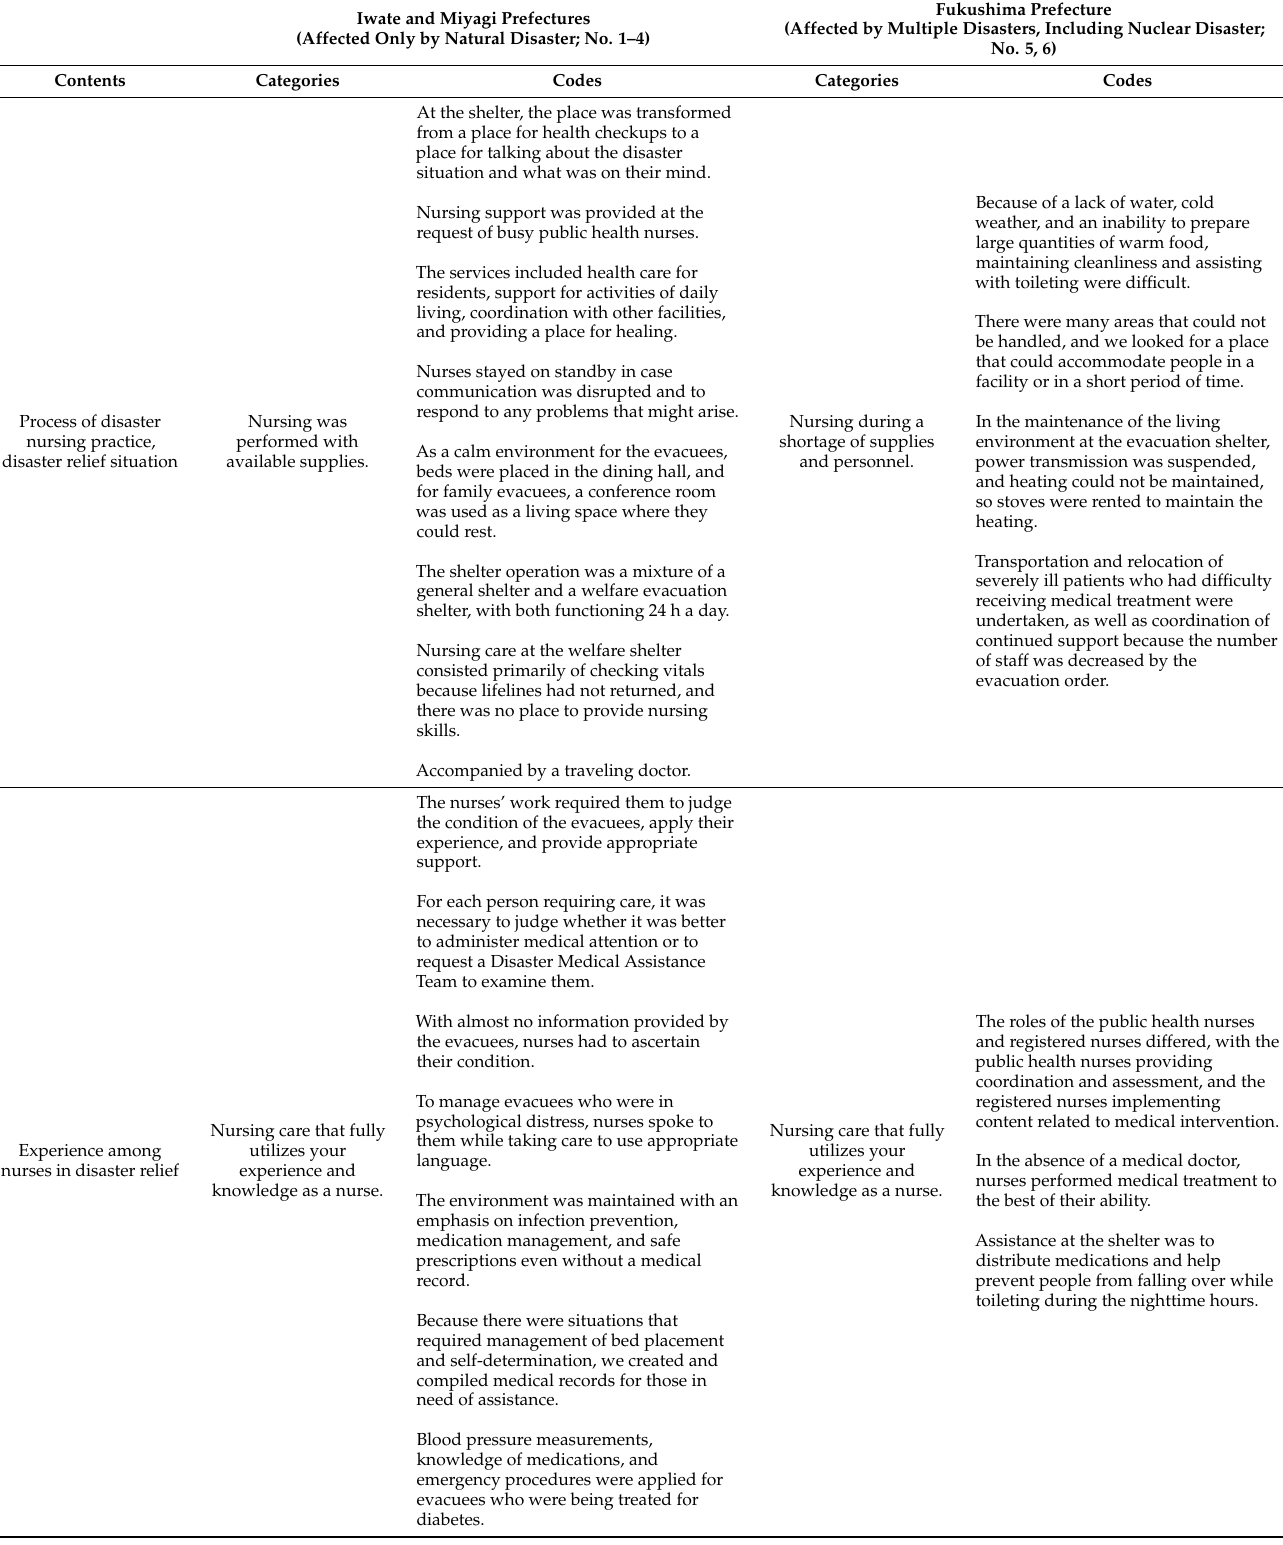
Table 2. Comparison of disaster nursing contents and situation from each